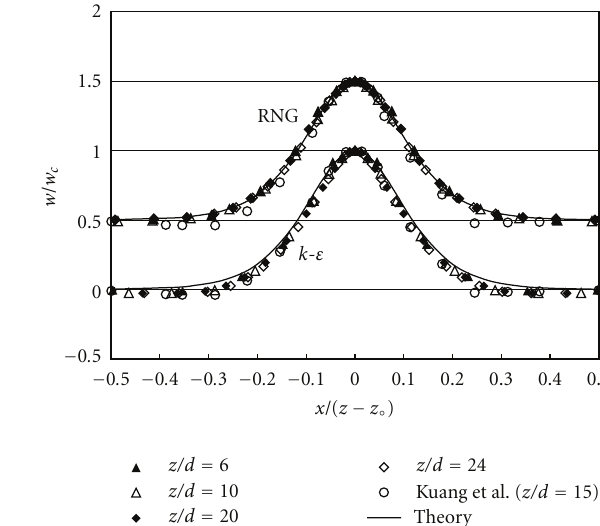
Figure 3: Centerline velocity variation.